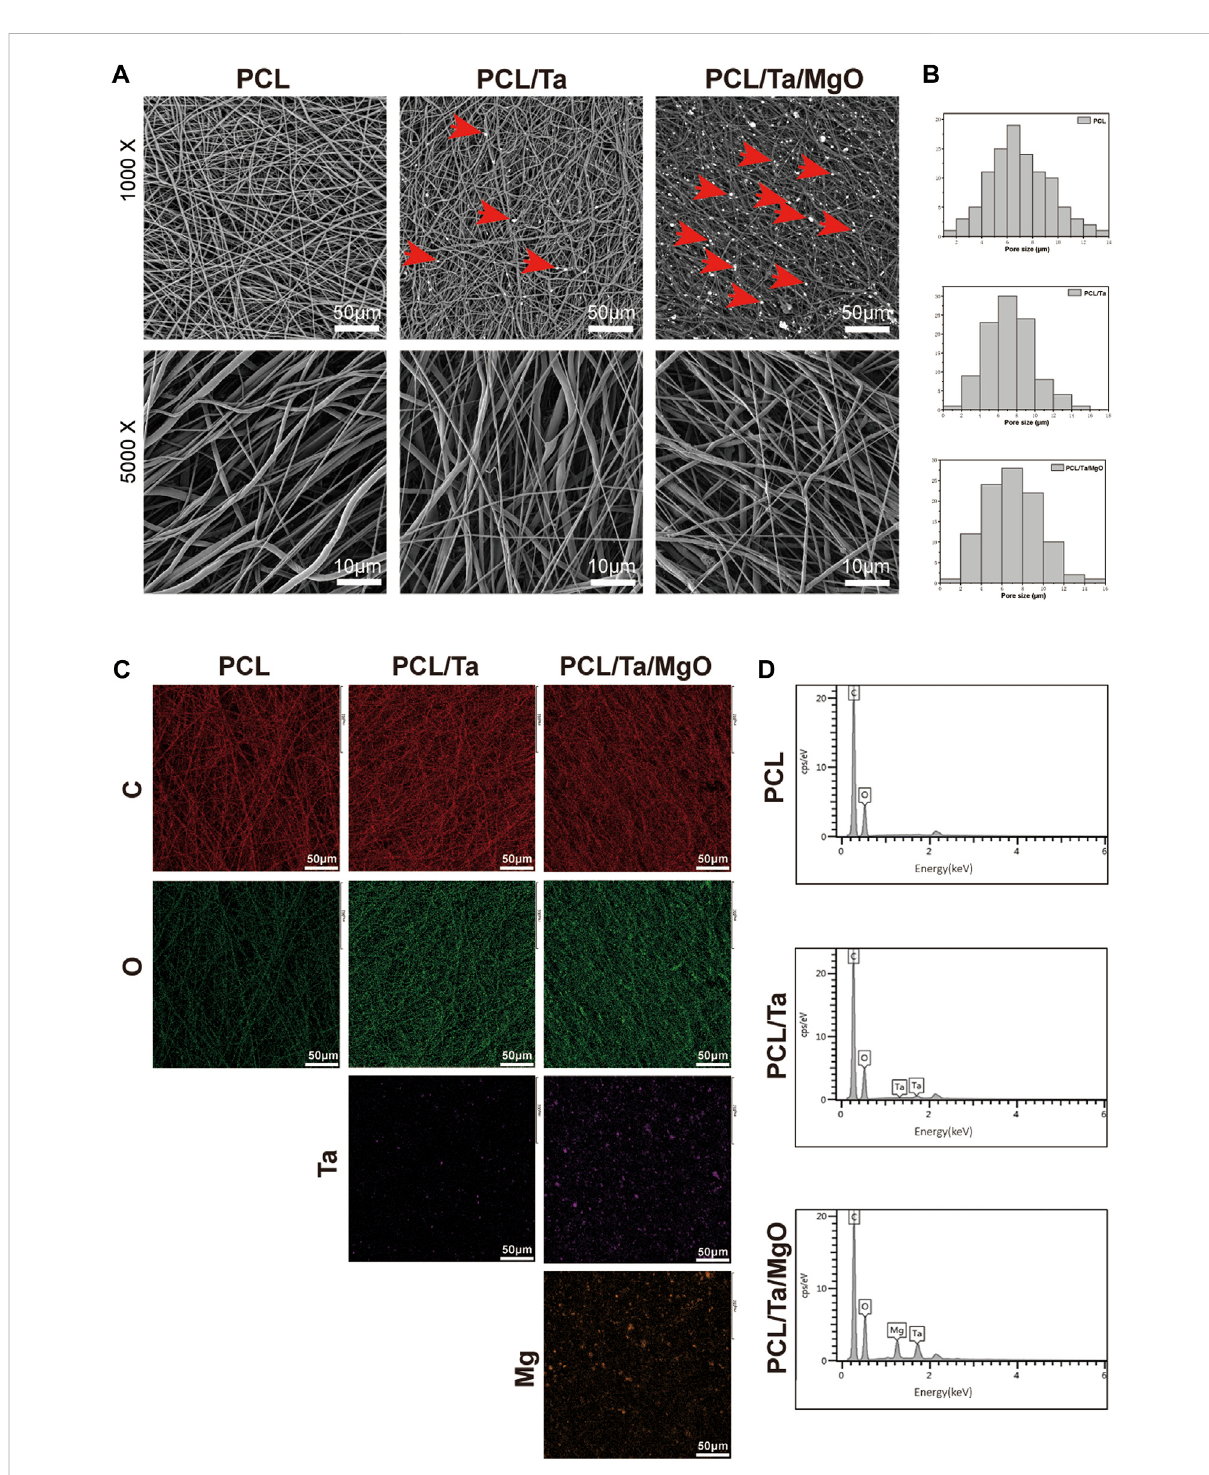
FIGURE 1 Morphological characterization and elemental analysis of different membranes. (A) SEM images at different magni fi cations. Red arrows: tantalum or magnesium oxide nanoparticles. (B) Distribution of pore sizes on the surface. ( n = 100) (C) Element mapping. (D) EDS